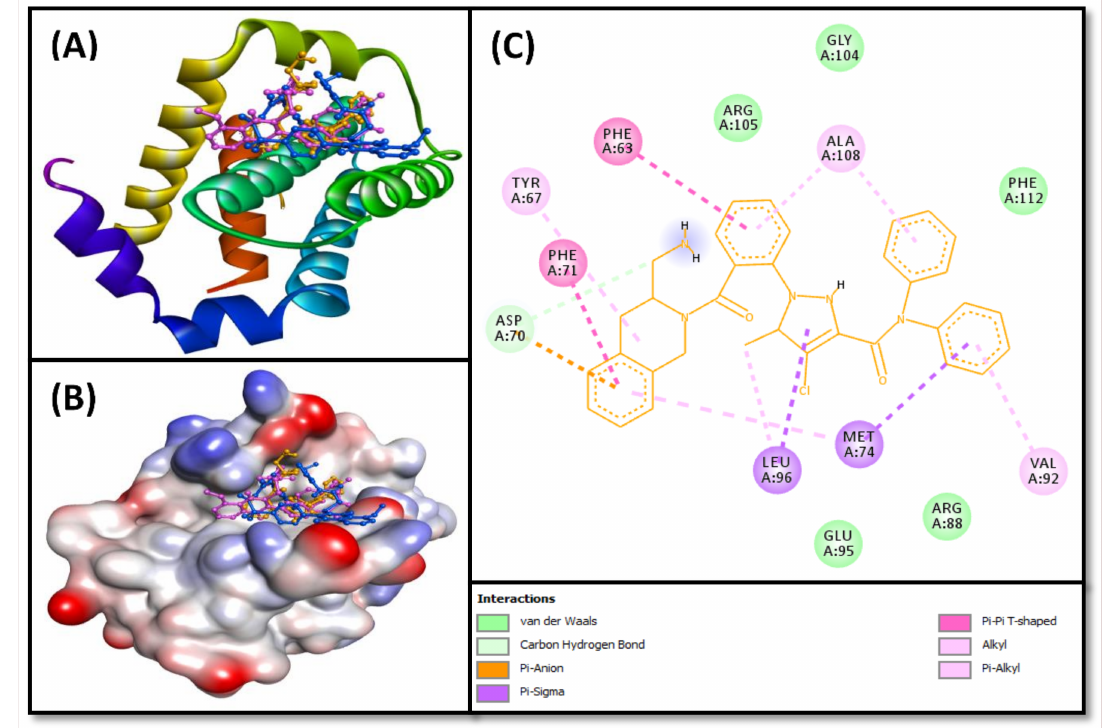
Figure 8. ( A ) 2D cartoon representation of the binding of DRO (control ligand), compounds 4d and 4f at the binding site of the Bcl-2 protein, and ( B ) 3D representation of the binding of DRO (control ligand), compounds 4d and 4f at the binding site of the Bcl-2 protein. DRO, compounds 4d and 4f are represented by gold, pink, and blue, respectively. ( C ) Molecular docking and interaction between Bcl-2 protein and DRO (control ligand).